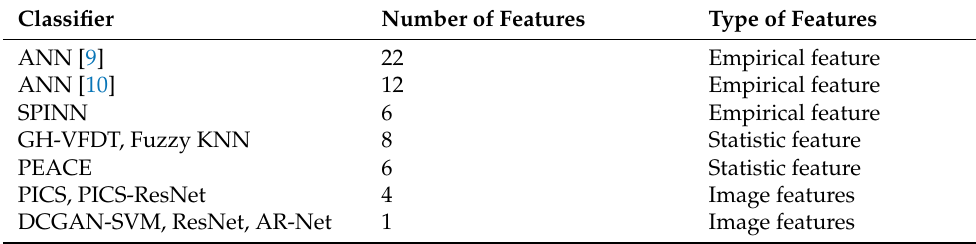
Table 1. The features used in different